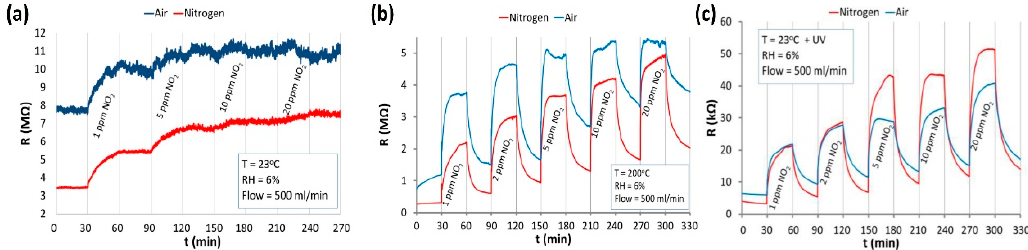
Figure 22. NO 2 sensing of ZnO nanostructures in different atmospheres of synthetic air and nitrogen at: ( a ) room-temperature (RT); ( b ) elevated temperature of 200 °C; ( c ) RT and UV irradiation. Reproduced with permission from [44].